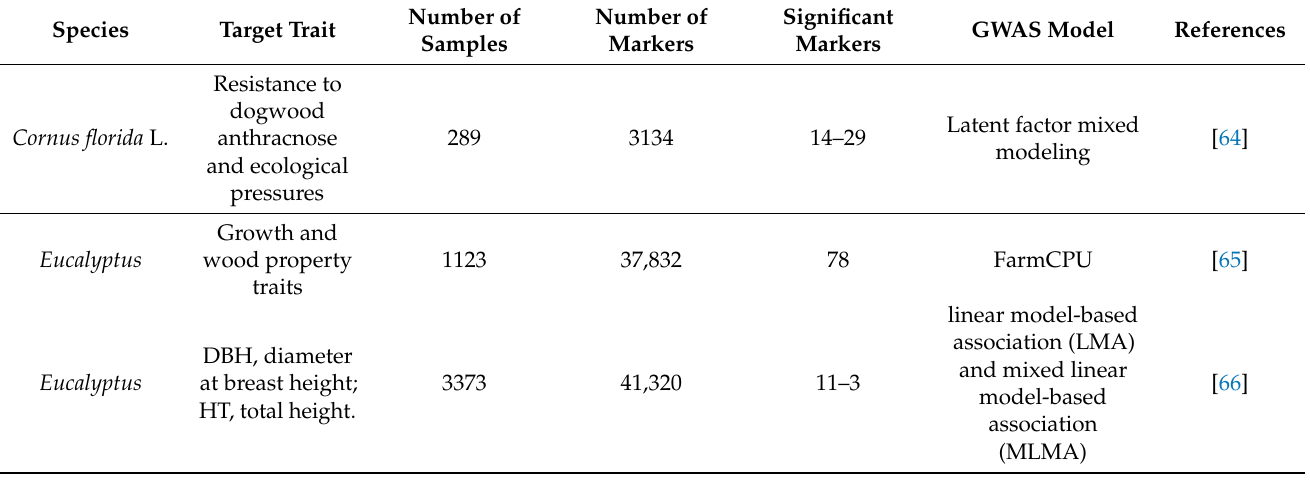
Table 1. Several significant marker-trait (SNP and DArT) associations found by GWAS models in different forest tree